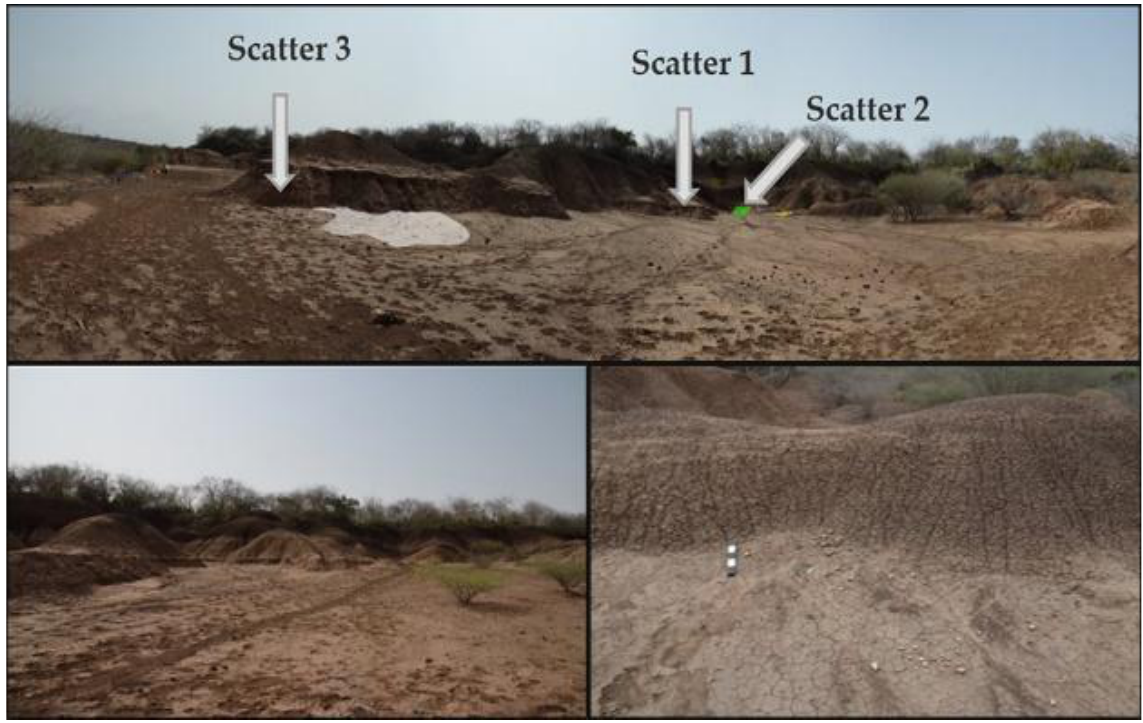
Figure 3. GOT 1-S Main Site and location of the scatters on the top; Gotera sporadic finds on the